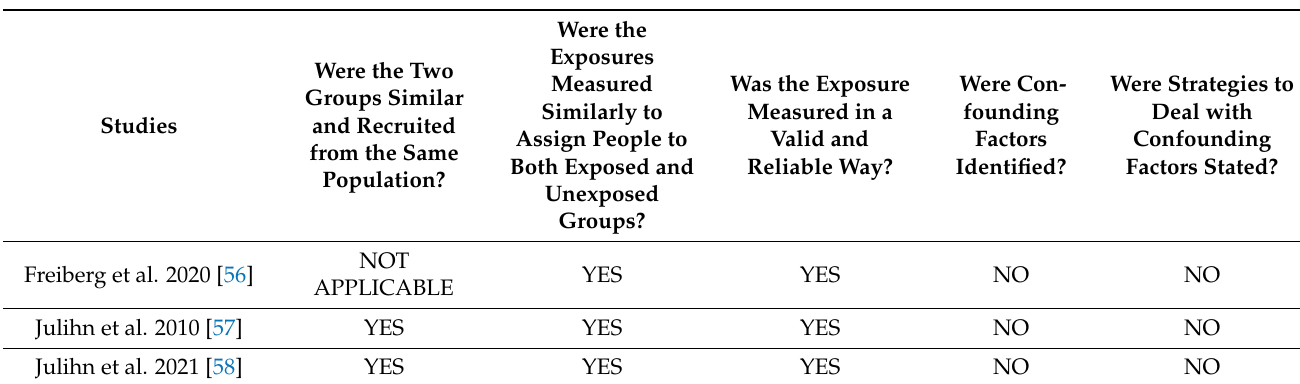
Table 3. JBI for cohort studies: population, exposure, confounding